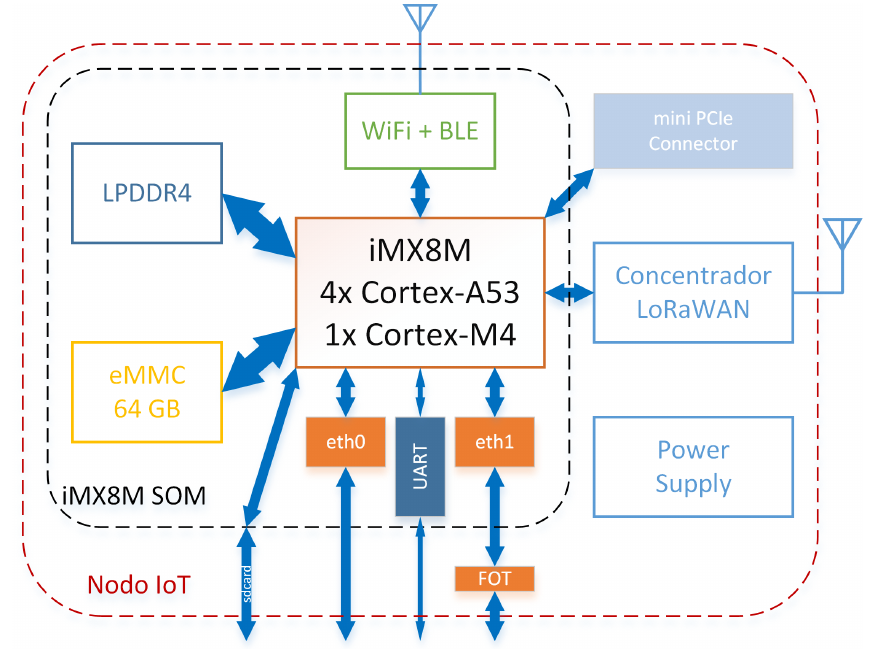
Figure 6. Block diagram of the IoT